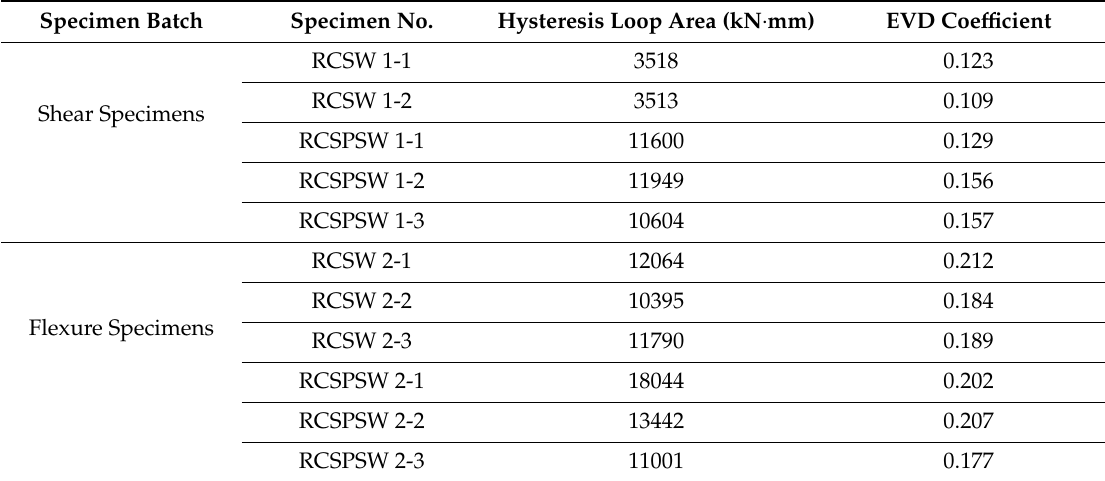
Table 5. Equivalent Viscous Damping (EVD) Coe ffi cients of All